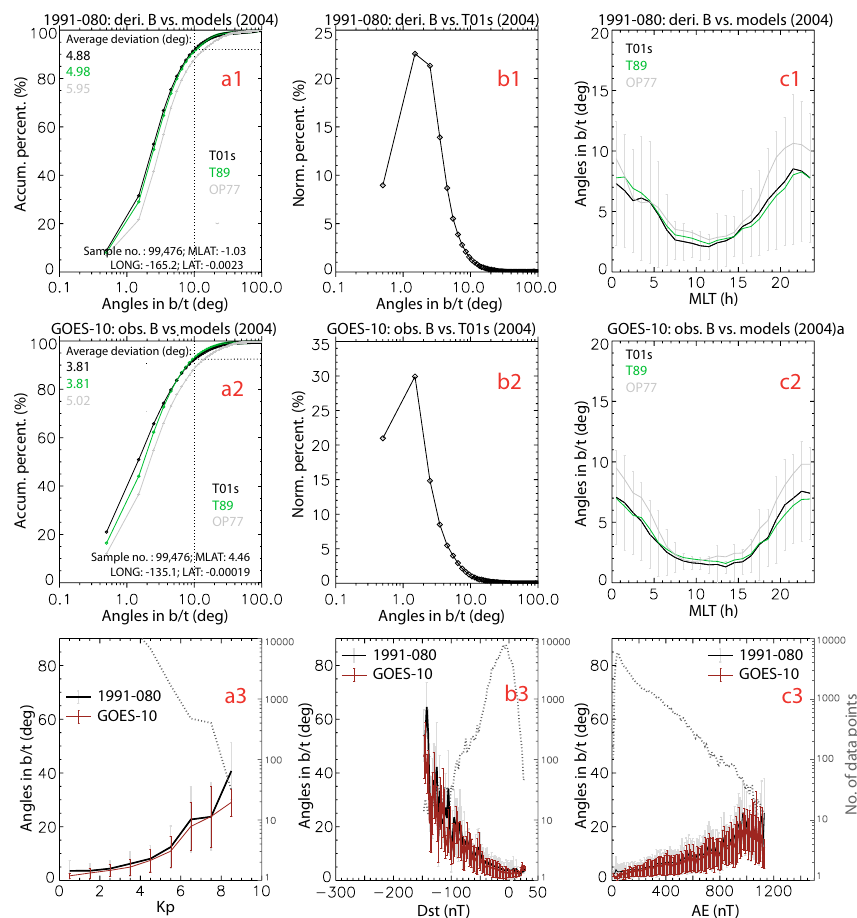
Figure 3. Statistical studies comparing derived, real (measured), and model magnetic field directions in 2004. Panels in the top row are for 1991-080. (a1) Accumulative percentage vs. deviation angles between derived and modeled directions for the three empirical models T01s (black), T89 (green), and OP77 (gray). Mean angle values as well as satellite coordinates are also presented. (b1) Normalized percentages vs. deviation angles for T01s. (c1) Deviation angles are binned to MLT for the three models, and the vertical gray bars are the errors for T01s model. Panels in middle row are for GOES-10 in the same format except for comparing real and modeled directions. (a3) Deviation angles are binned to Kp for 1991-080 (black) and GOES-10 (red) using T01s model. Again the vertical bars are errors for each. The gray dotted line plots data sample number in each bin (read by the vertical axis on right). (b3) Deviation angles are binned to Dst. (c3) Deviation angles are binned to the Auroral Electrojet Index